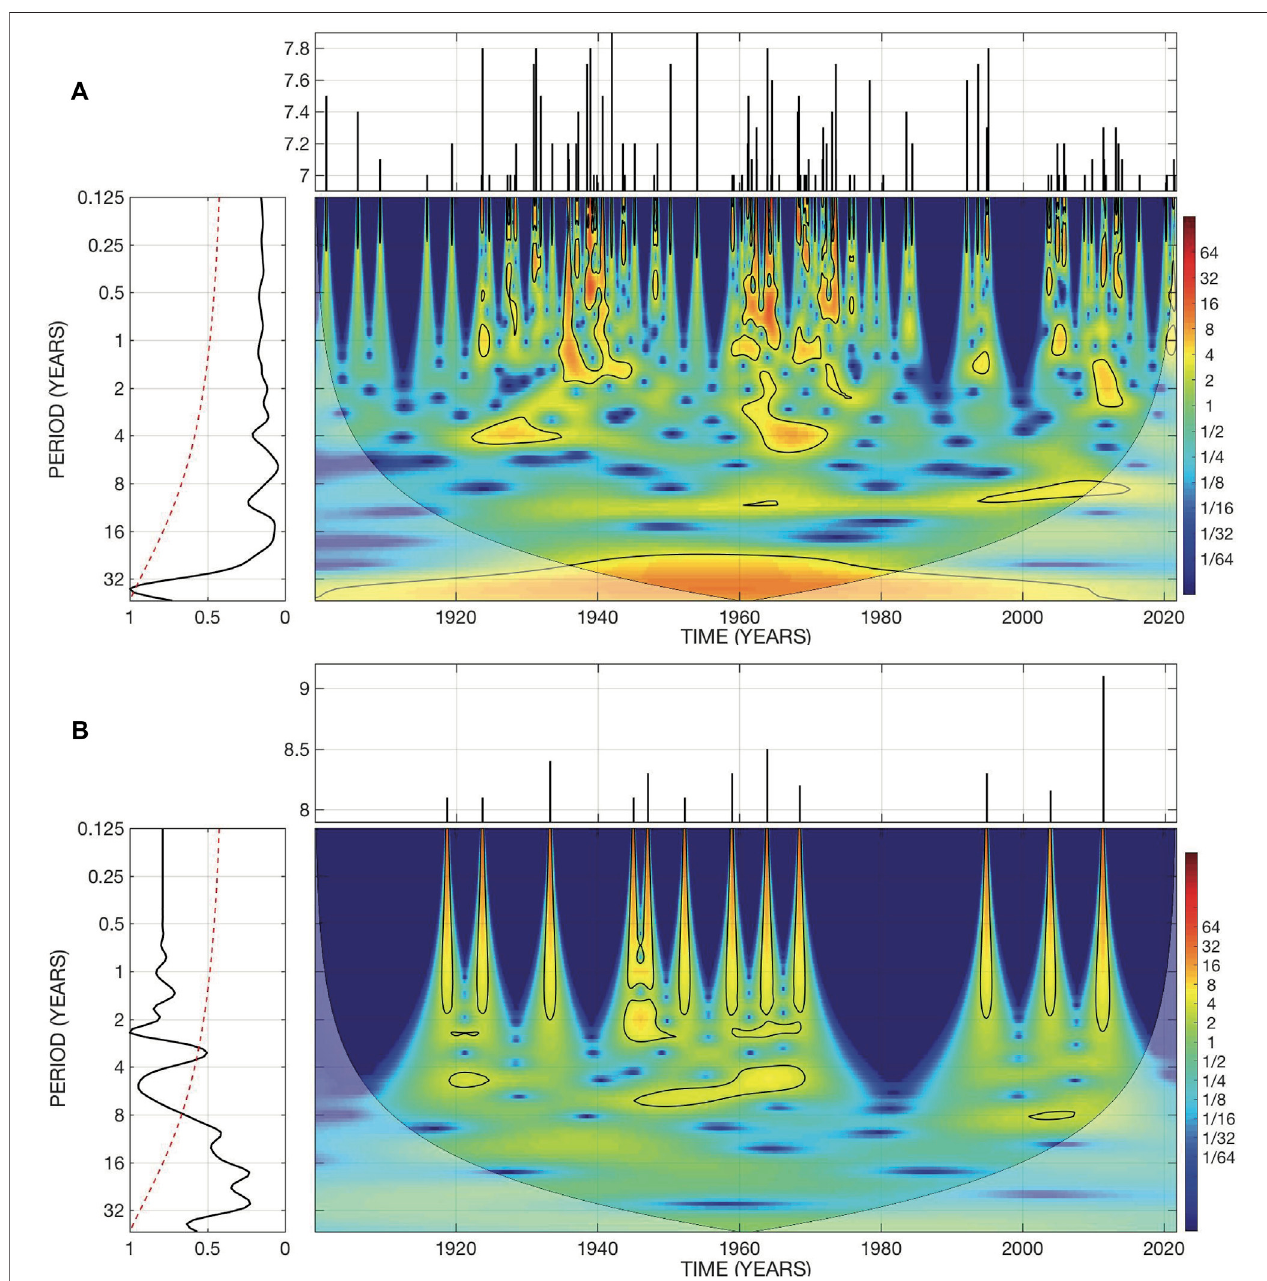
FIGURE10| Resultsofthetime-frequencywaveletspectralanalysisofearthquaketimeseriesrecordfortheJapaneseseismiczonebetween1900and2021,with magnitude: (A) 7 ≤ M < 8. (B) greaterthanorequalto8.Theglobaltime-averagedwaveletperiod(leftpanel)withthereddashedlineindicatingthe95%con fi dencelevel drawn from a red noise spectrum. The Morlet wavelet power spectral density (MWPSD) in arbitrary units adopting the red-green-blue colour scales (central panel). The coneofin fl uenceshowsthepossibleedgeeffectsintheMWPSD(i.e.,theU-shapedcurvesoutsideofwhichthespectralinformationcanbeconsideredunreliable).